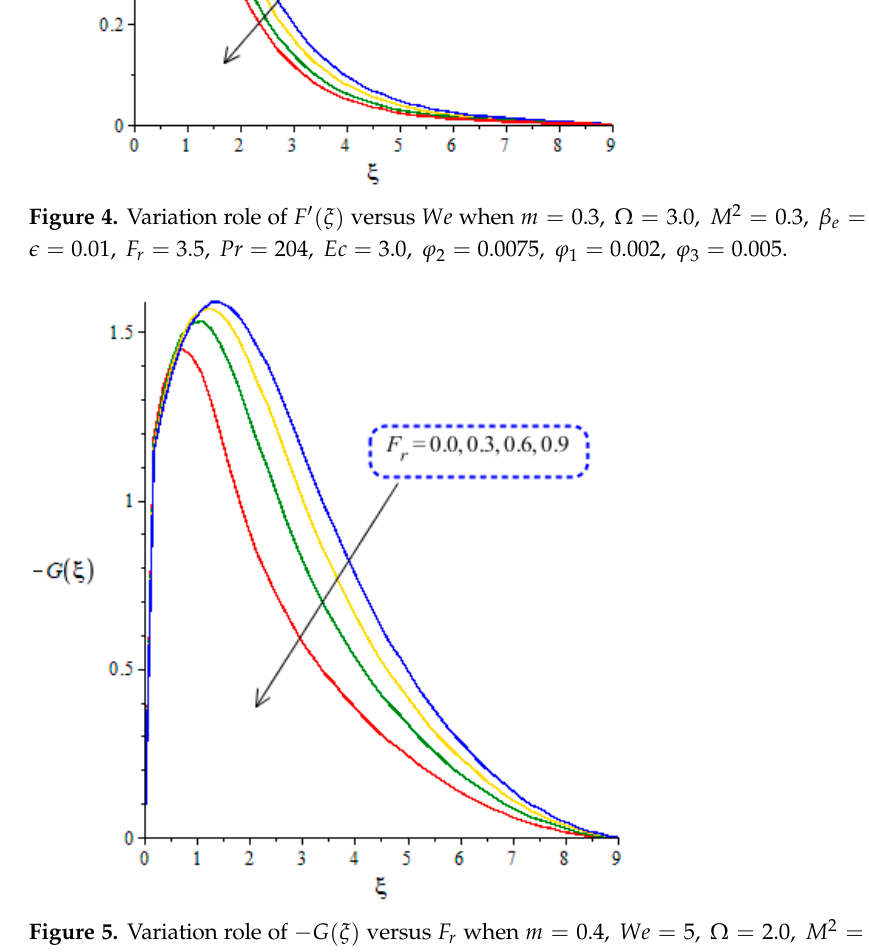
Figure 6. Variation role of 𝐹′(𝜉) versus 𝐹 (cid:3045) when 𝑚 = 0.3, 𝑊𝑒 = 3, Ω = 2.0, 𝑀 (cid:2870) = 0.33,𝛽 (cid:3032) = 0.2, 𝛽 (cid:3036) = 0.01,𝜖 = 0.01, 𝑃𝑟 = 204, 𝐸𝑐 = 0.34,𝜑 (cid:2870) = 0.0075, 𝜑 (cid:2869) = 0.002,𝜑 (cid:2871) = 0.005.